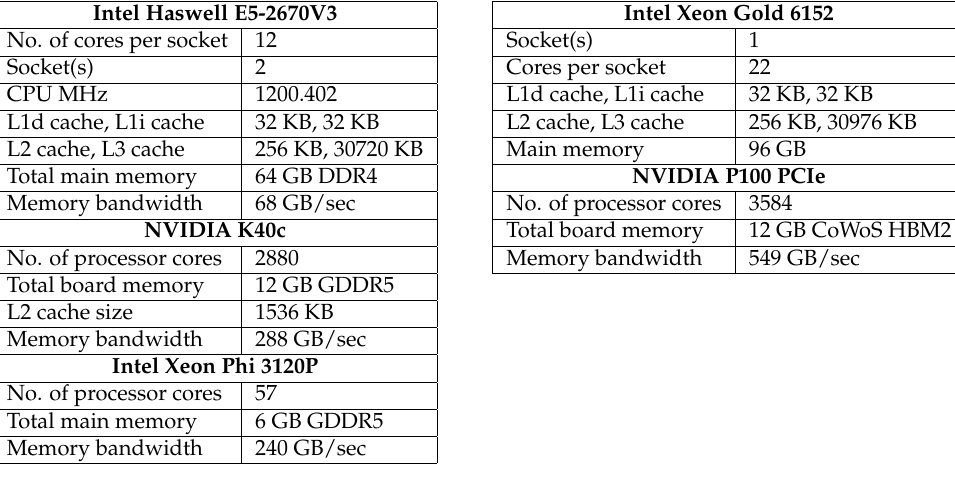
Figure 1. Specifications of the five heterogeneous processors, Intel Haswell multicore CPU, Nvidia K40c, Intel Xeon Phi 3120P, Intel Skylake multicore CPU and Nvidia P100 PCIe. Fans are significant contributors to energy consumption. On our hybrid nodes, fans are controlled in zones: (a) zone 0: CPU or system fans; (b) zone 1: peripheral zone